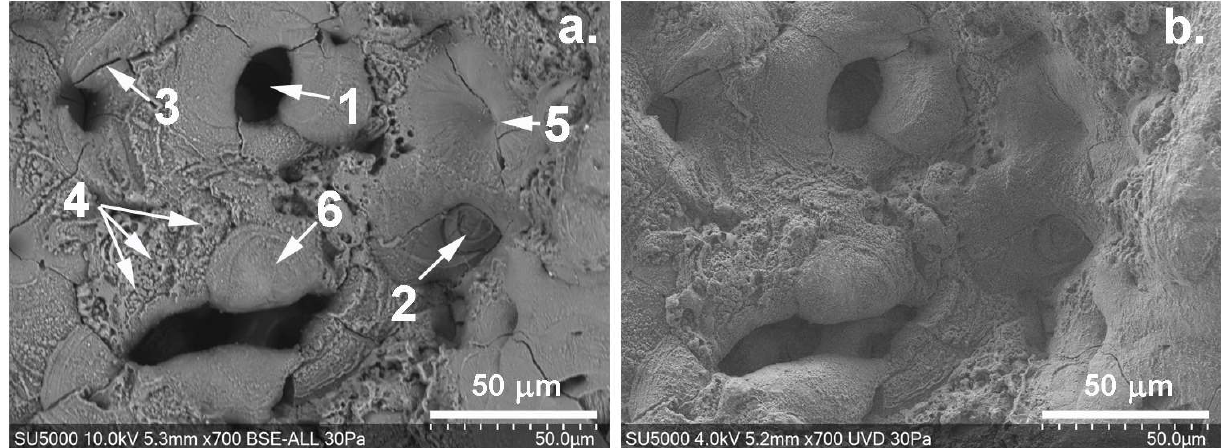
Figure 2. SEM micrographs in BSE ( a ) and SE ( b ) mode of a representative area of the PEO coating surface for the sample AZ63_20m.